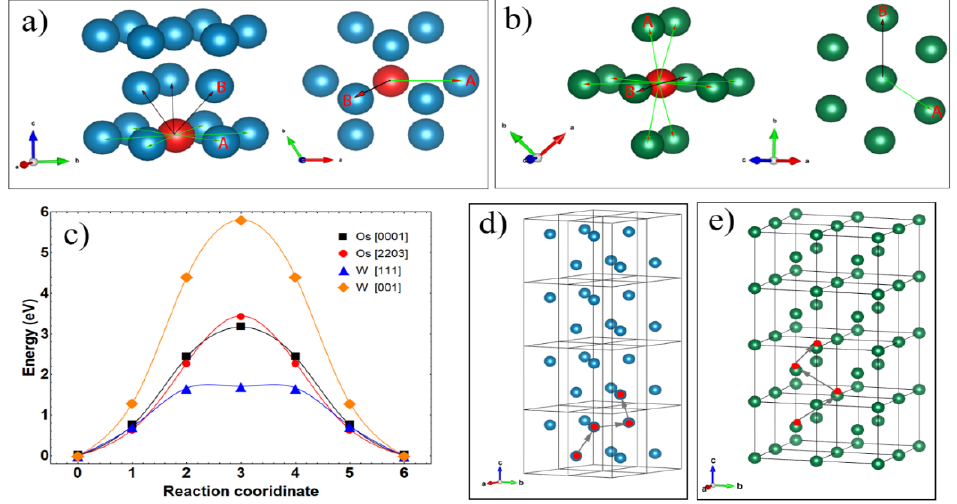
Figure 10. Inner vacancy migration of ( a ) Os with direction A <0001> and B<2203>, ( b ) W with direction A <001> and B<111>, ( c ) energy barriers, ( d ) path example of Os, and ( e ) path example of